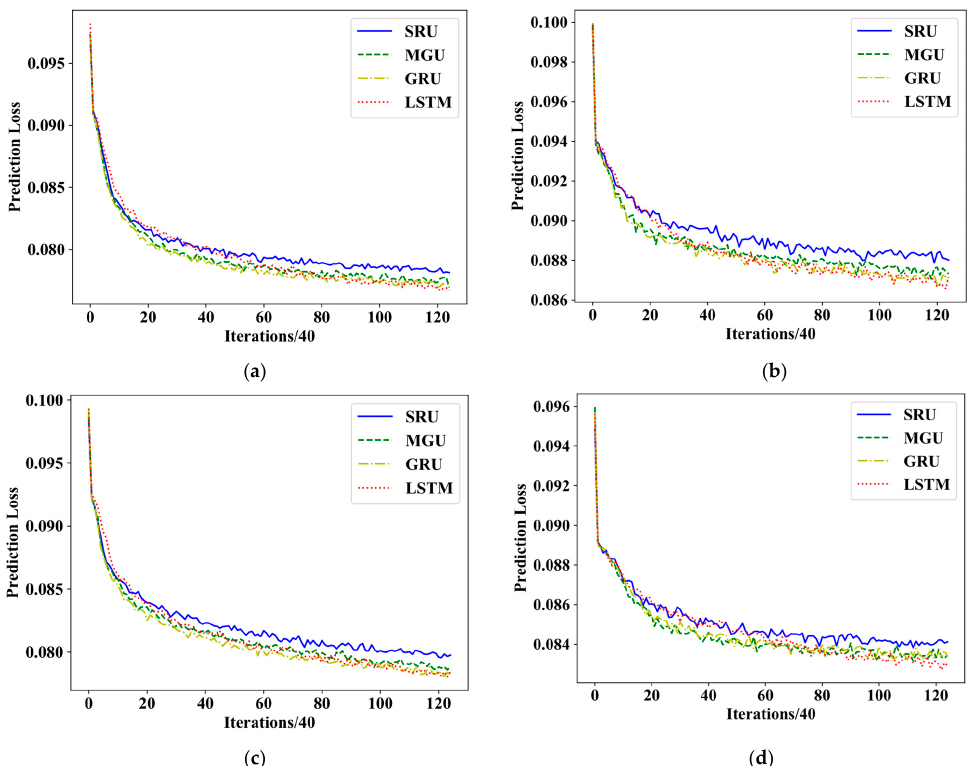
Remote Sens. 2022 , 14 , 5439